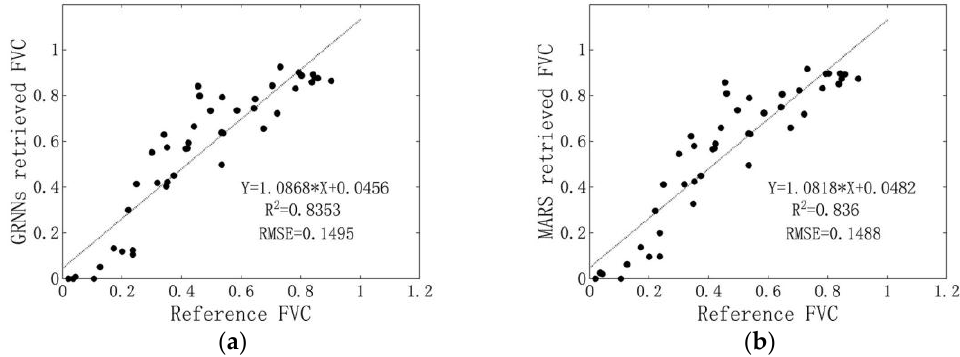
Figure 6. Scatterplots of FVC estimated using the two methods (( a ) MARS method; ( b ) GRNNs method) against the ground FVC measurements.